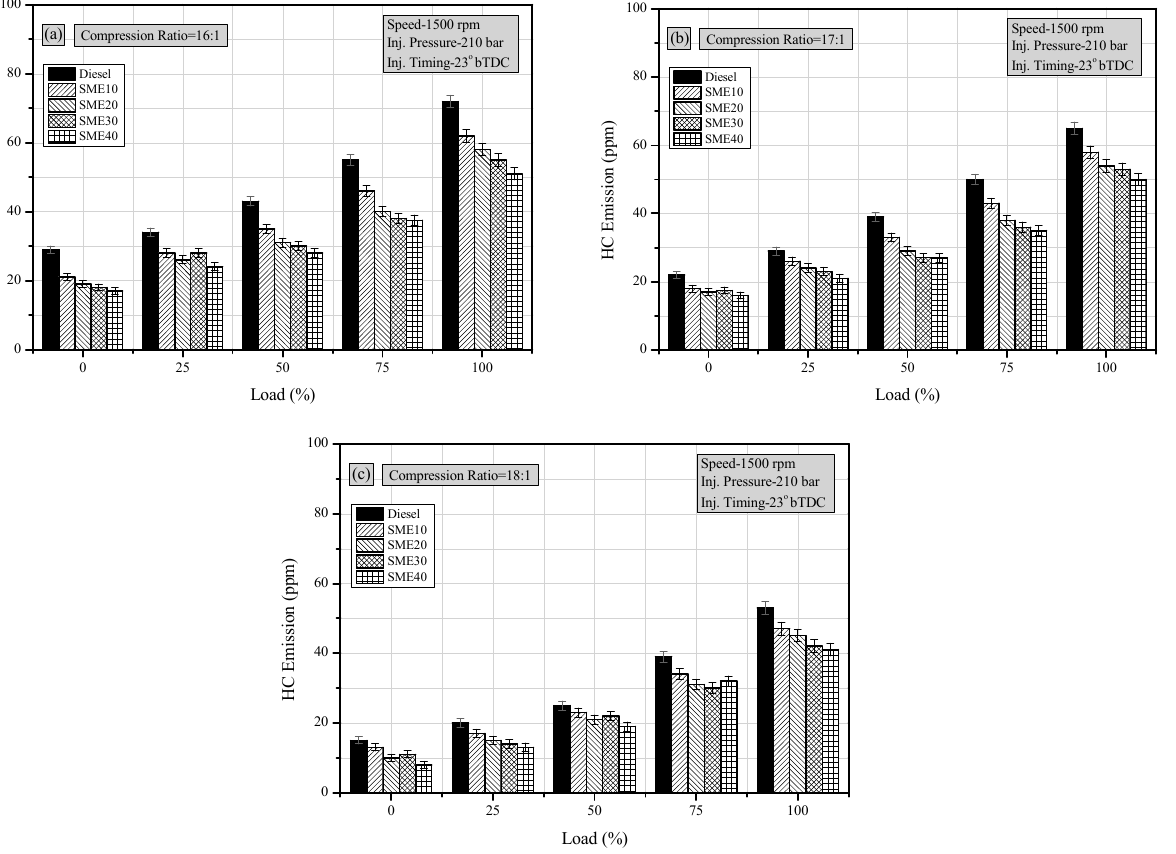
Figure 8. Variation of HC with load for the fuel blends at CRs: ( a ) 16:1 ( b ) 17:1 ( c ) 18:1. Nitrogen oxides (NO x ) are primarily composed of NO, with minor quantities of NO 2 .